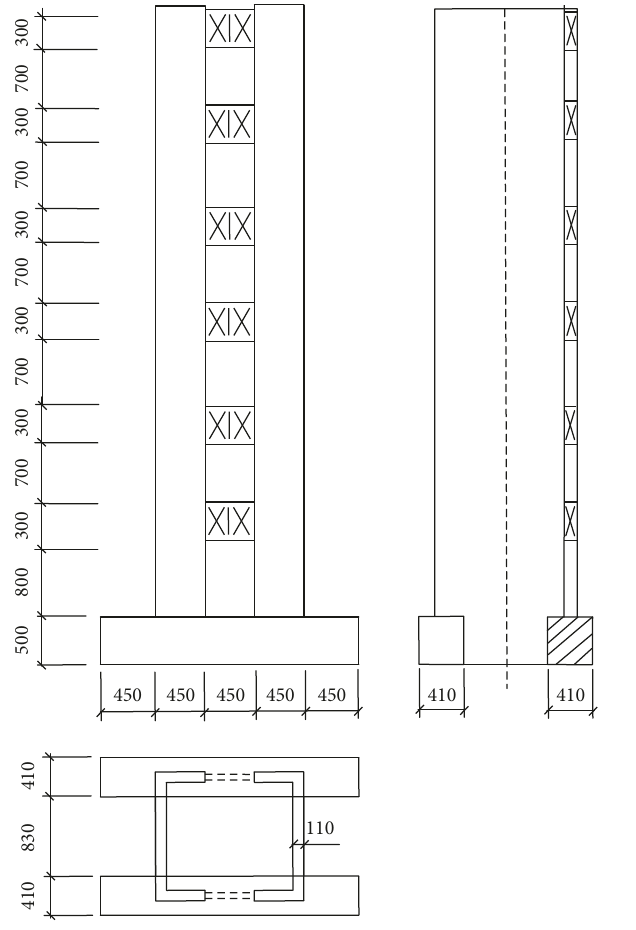
Figure 12: Multilevel shear wall model with steel truss coupling beam.